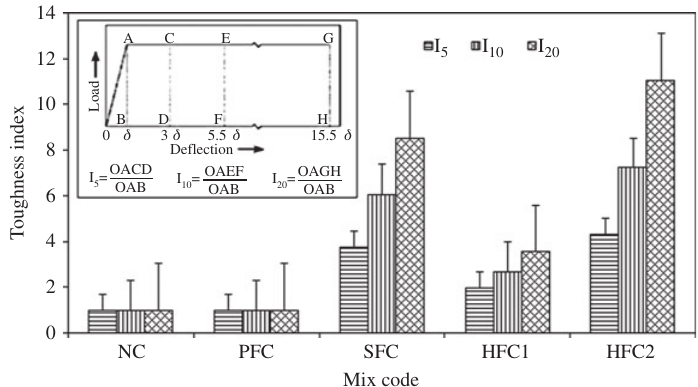
Figure 5 Toughness indices of concrete series with different fi ber contents.